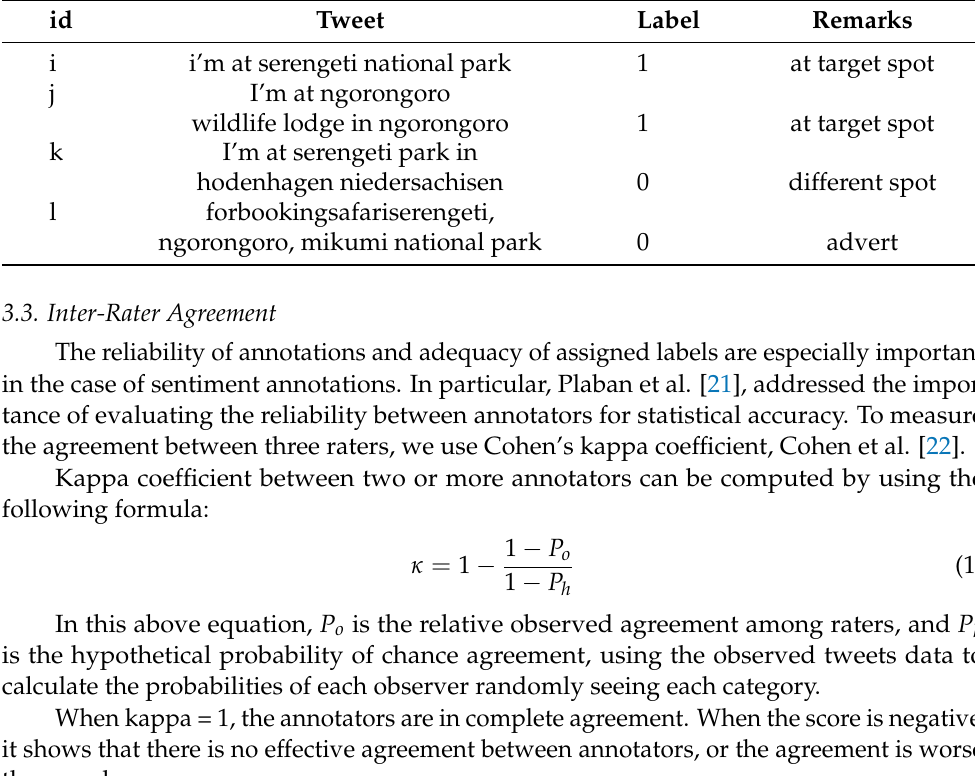
Table 3. Examples of annotation made from location-clustered tweets. id